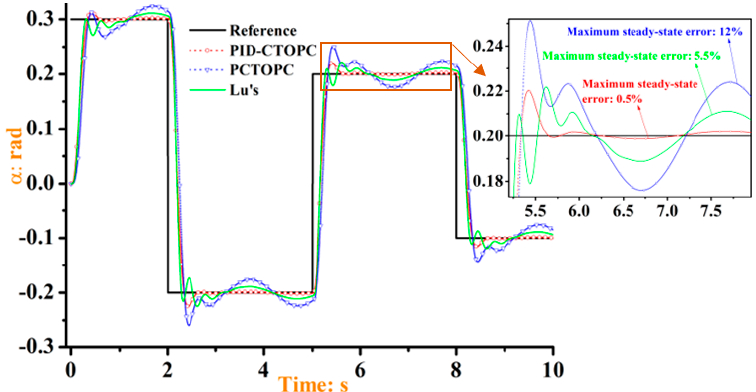
Figure 4. Group 2 with time-varying disturbance: Attack angle α .